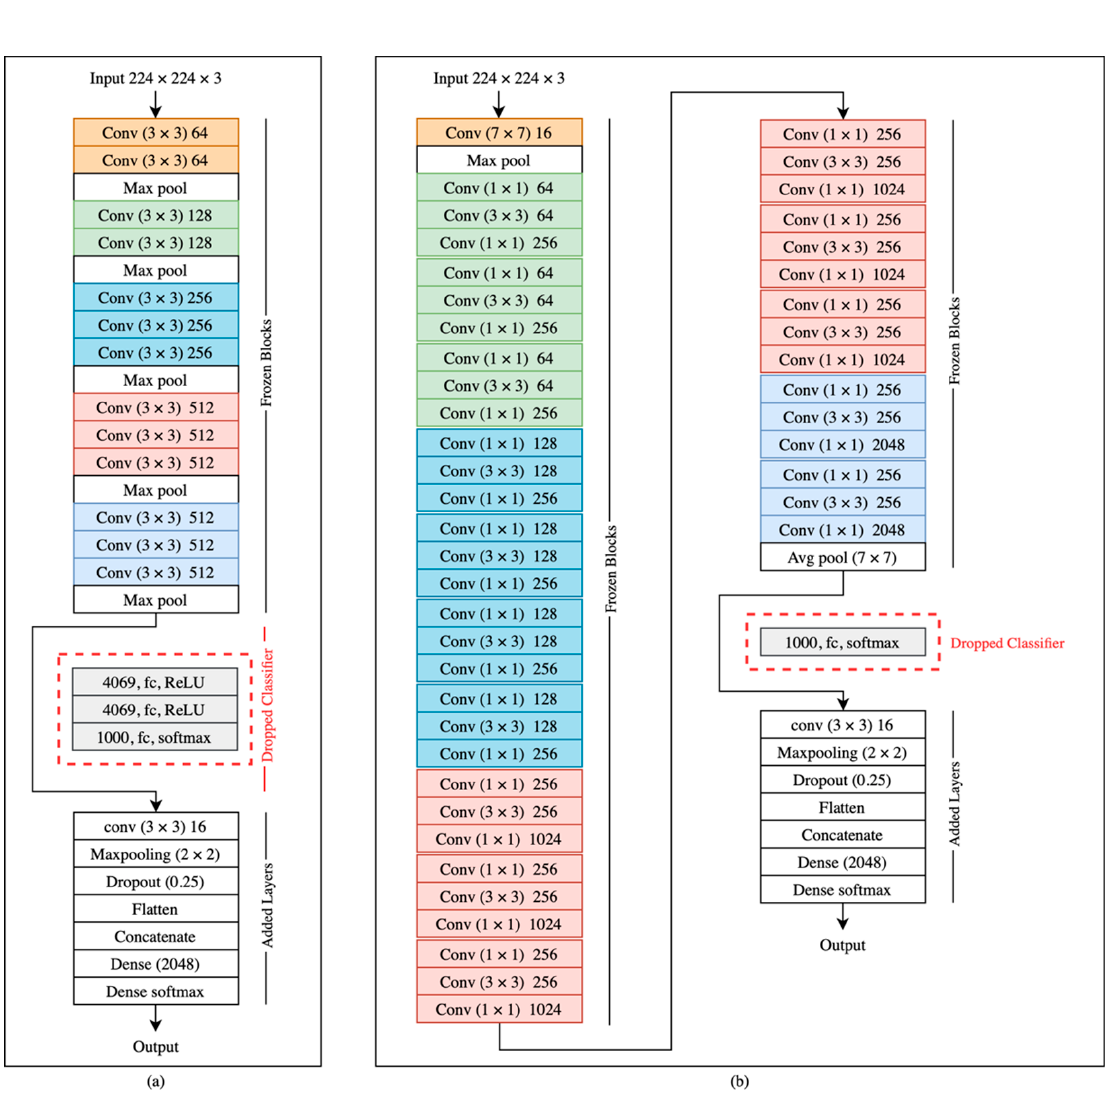
Figure 4. The transfer learning using ( a ) VGG16 and ( b )ResNet50.